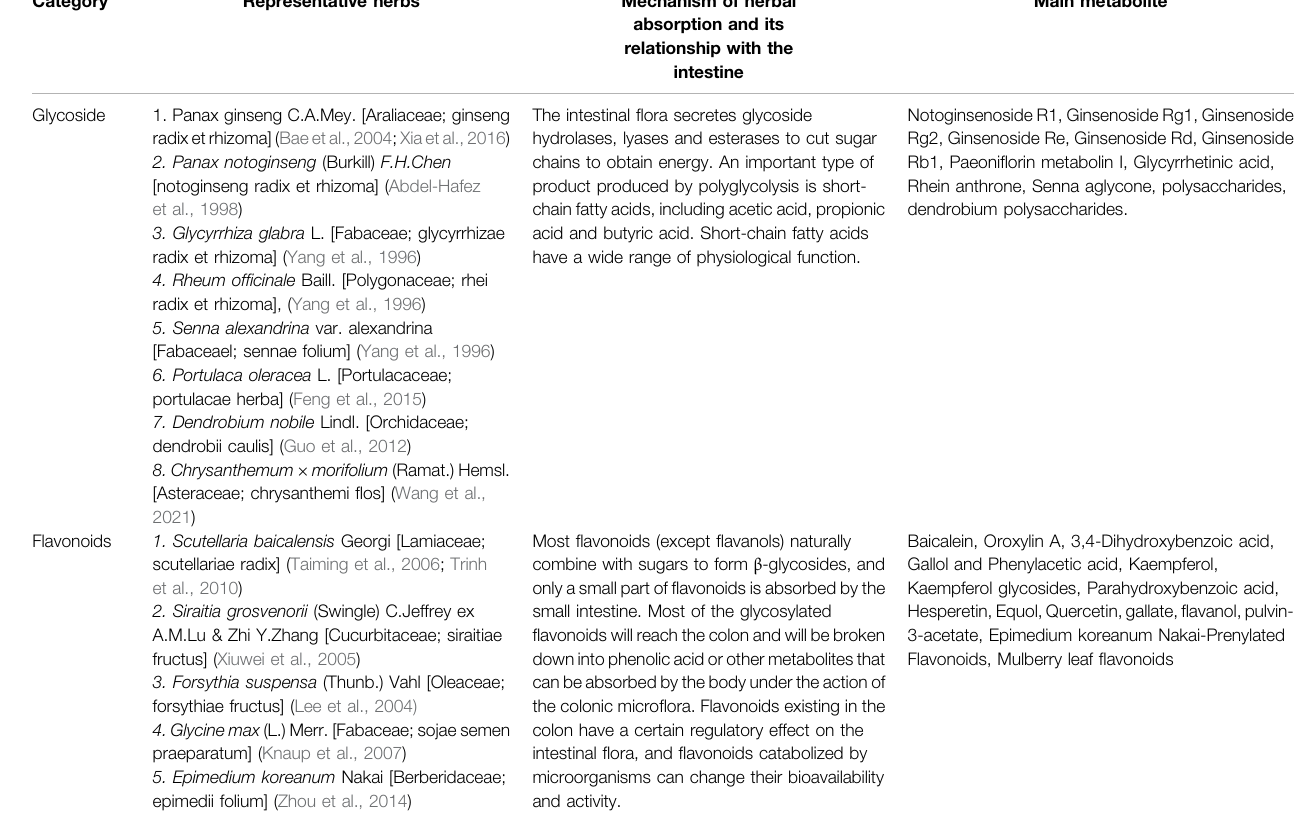
TABLE 1 | The interaction between the effective ingredients of traditional Chinese medicine and the intestinal fl ora Category Representative